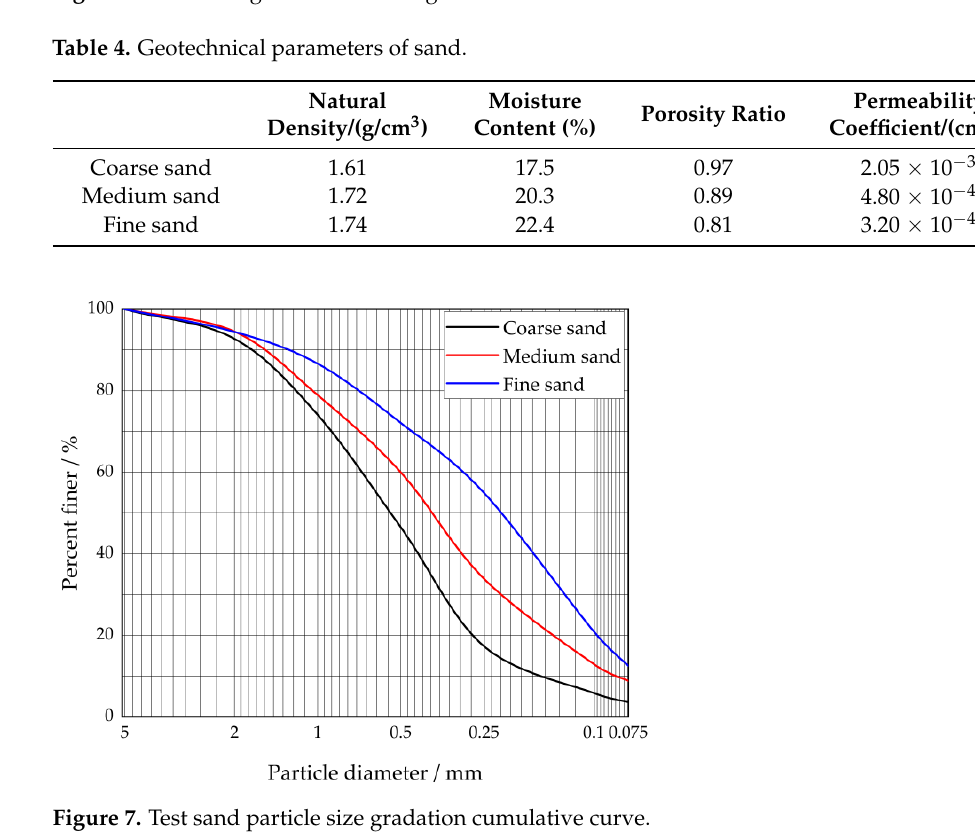
Figure 6. Model diagram of the test rig.